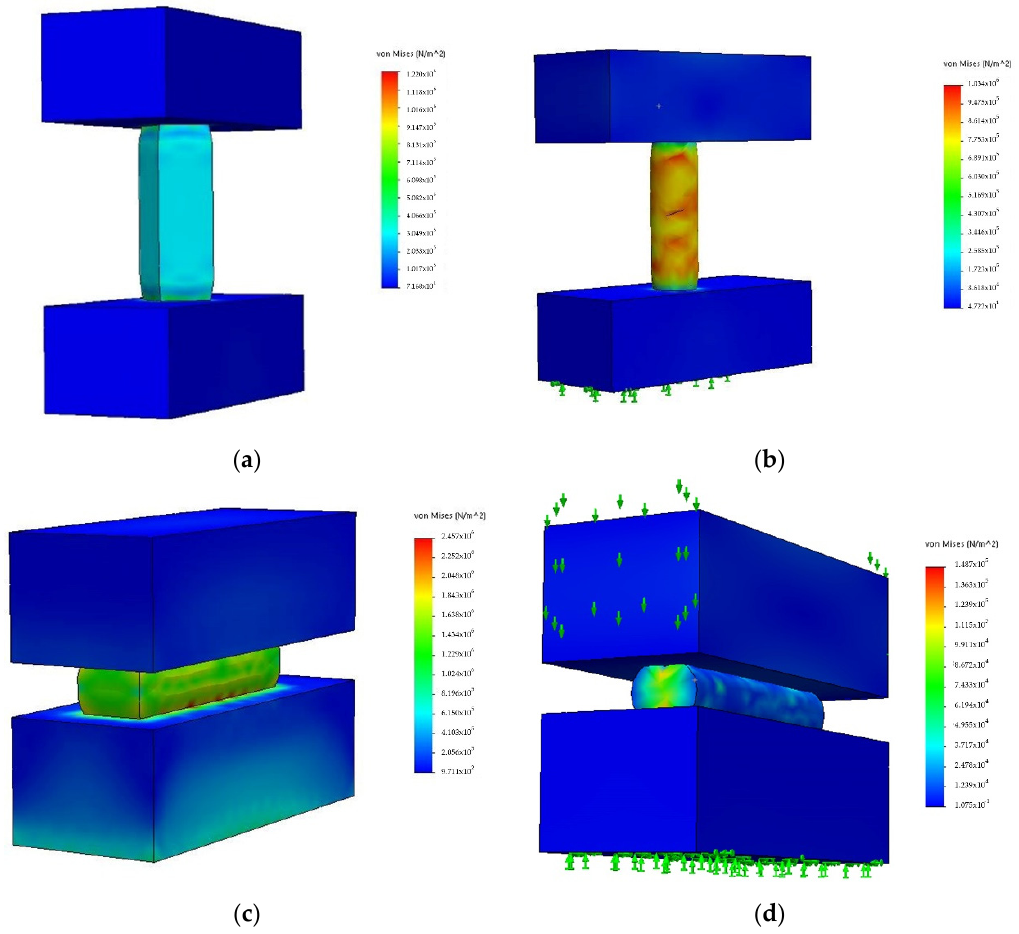
Figure 3. Simulation of specimen compression: ( a ) simulation of prismatic specimen in vertical orientation; ( b ) simulation of cylindrical specimen in vertical orientation; ( c ) simulation of prismatic specimen in horizontal orientation; ( d ) simulation of cylindrical specimen in horizontal orientation.